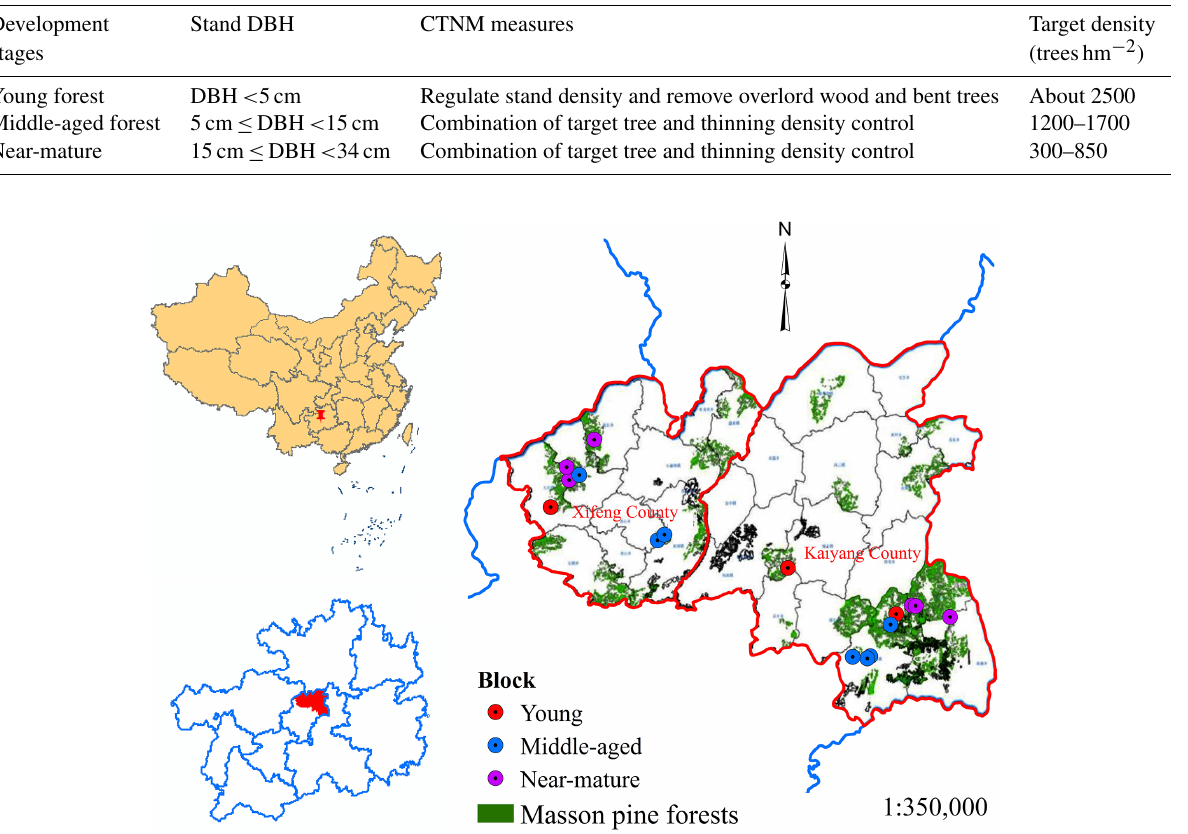
Figure 1. The distribution of the 19 sample blocks (Chai and Tan, 2020). relative dominance (Rd) = dominance of onespecies × 100% , domiance of all species IV = (RD + RF + Rd) / 3